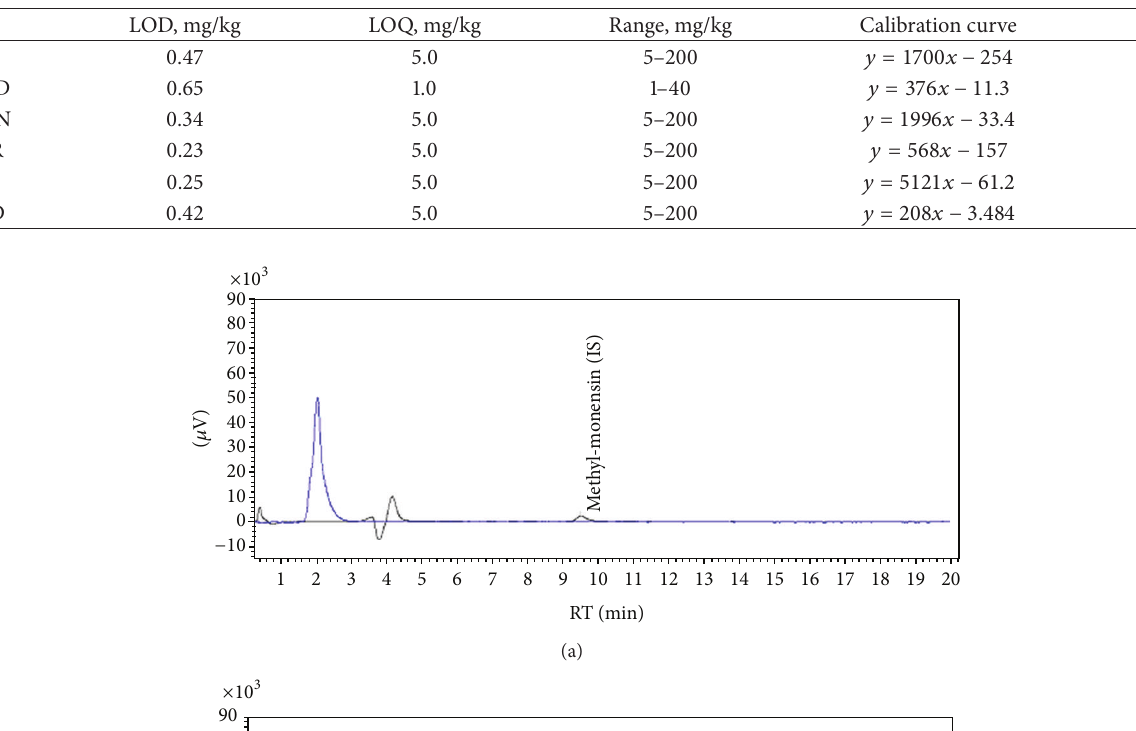
Table 2: The results of in house validation: sensitivity and linearity data.